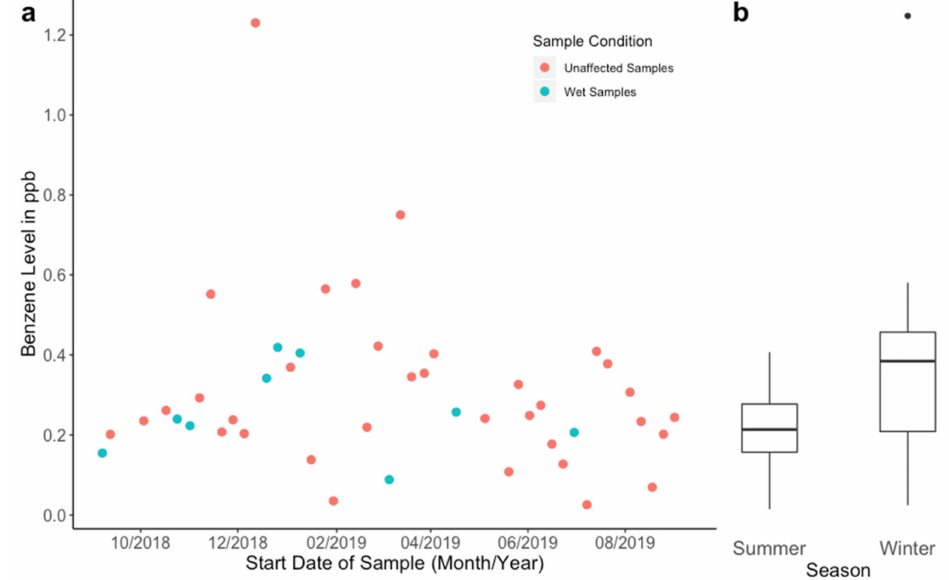
Figure 3. Seasonal changes in benzene levels. Each point ( a ) is plotted by the start date of the sampling week. ”Summer” and “winter” value boxplots ( b ) encompass three months of data, and were statistically significantly di ff erent at the 90% confidence level ( p <